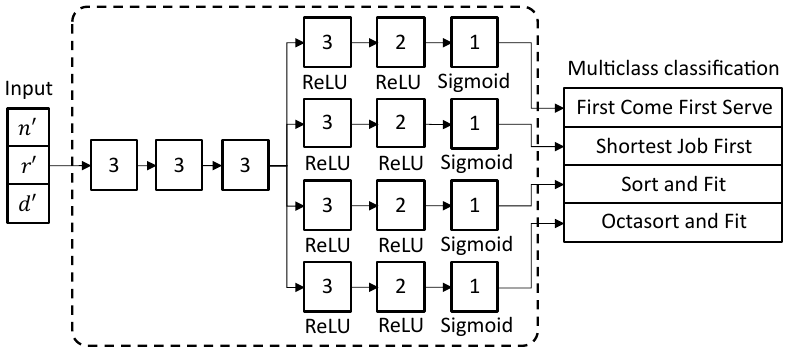
Figure 4. Multi-task learning (MTL) with a hard parameter sharing approach is used to choose the best scheduling